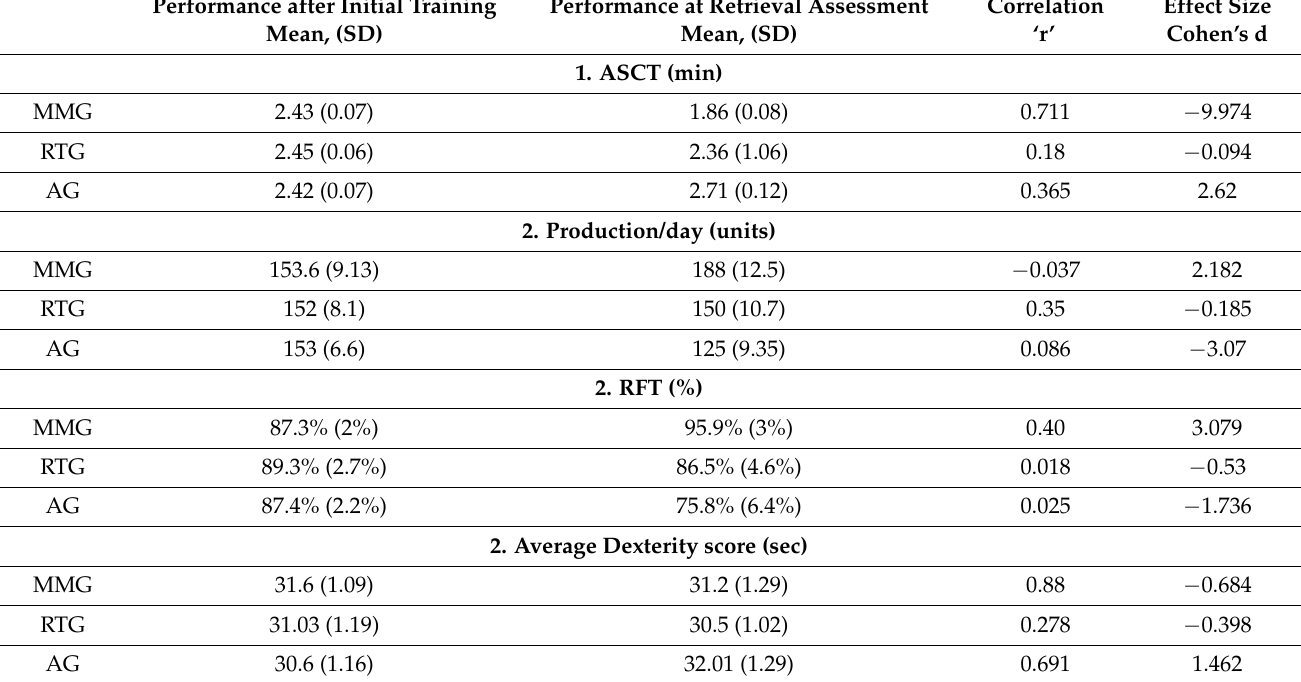
Table 4. Effect size among groups using the paired samples t